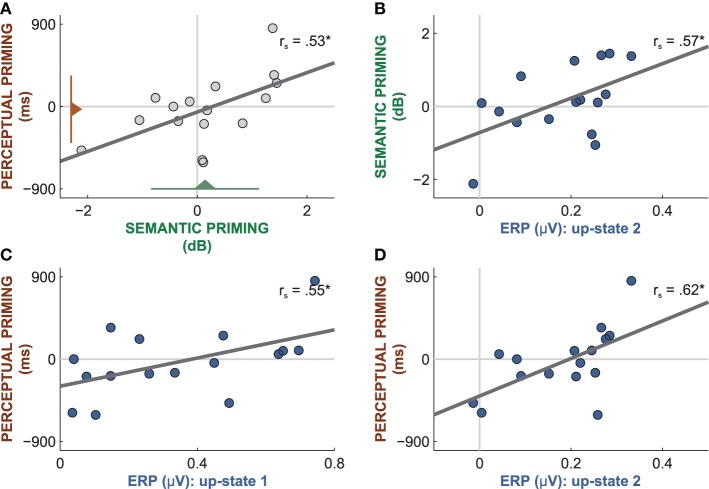
Correlations between word-related brain responses and the amount of priming. (A) Although the amount of priming was at chance level in both tests (triangles with lines reflect mean and standard deviation), perceptual and semantic priming were correlated. (B) The mean amplitude of the word-evoked up-state 1 predicted the amount of semantic priming. The mean amplitude of the word-evoked up-state 1 (C) and 2 (D) predicted the amount of perceptual priming. rs: Spearman correlations; *p < 0.05.